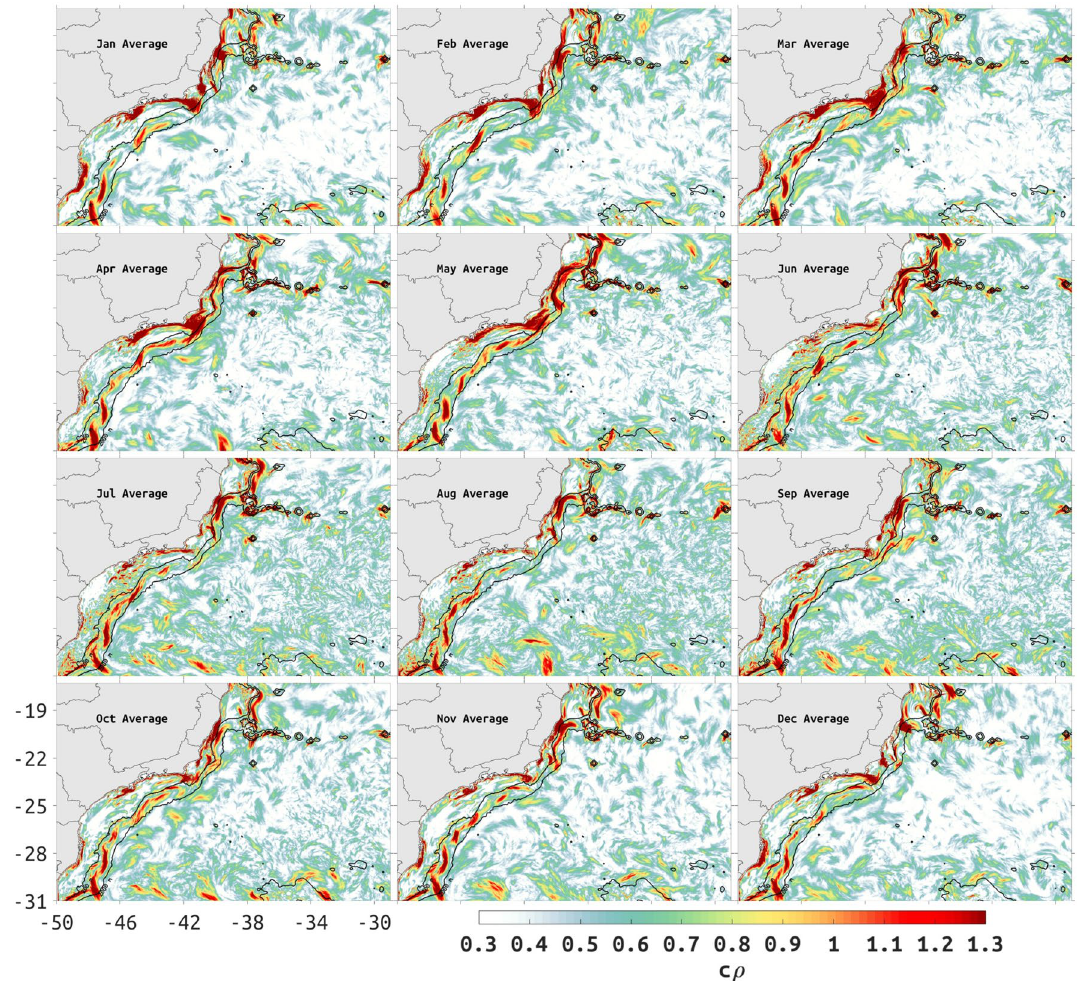
Figure 4. Monthly climatological attraction strength ( c ρ ) in the SWA. Note the discontinuous meridional distribution of high (red) c ρ values between the 200- and 2000-m depth contour lines (thin black lines). Created with Matlab R2018B (www.mathw